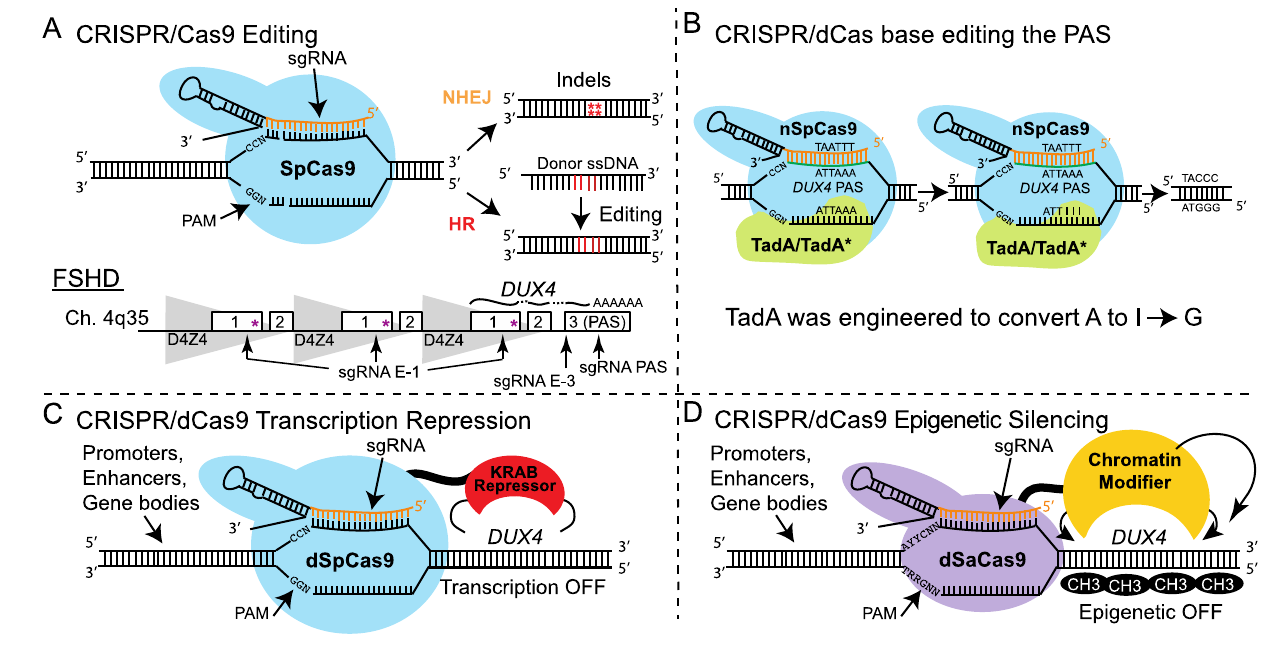
Figure 3. CRISPR gene modification approaches to FSHD. ( A ) The Cas9 nuclease cuts DNA at sites targeted by single-guide RNAs (sgRNAs). DNA repair by nonhomologous end joining (NHEJ) mediates the disruption of genomic sequences by insertions/deletions (indels), whereas homology-directed repair (HDR) mediates precise editing in the presence of a donor template. CRISPR editing of the D4Z4 repeat (*) necessitates cutting the genome in hundreds of unintended places, as these repeats exist in many copies on the noncontracted 4q chromosome and both 10q chromosomes, in addition to polymorphic D4Z4s at other loci. Thus, groups attempting CRISPR editing have focused on the polyadenylation signal (PAS) in DUX4 exon 3, which provides a safer target. ( B ) RNA-programmable base editing utilizes a wild-type tRNA adenosine deaminase (TadA) and an engineered version of TadA (TadA*) fused as a dimer to a nicking version of Cas9 (nCas9). This enables adenine-to-guanine substitution without introducing double-stranded DNA breaks. ( C , D ) As an alternative strategy, enzymatically dead Cas9 (dCas9) is fused to the KRAB domain for transcription inhibition (panel C ) or to chromatin-modifying proteins, which can act in a broader fashion across the locus (panel D ). Fusing minimized versions of these regulators to dCas9 from Staphylococcus aureus allows packaging into rAAV vectors to silence pathogenic DUX4 expression in FSHD muscle. Additional abbreviation: PAM, protospacer-adjacent motif.